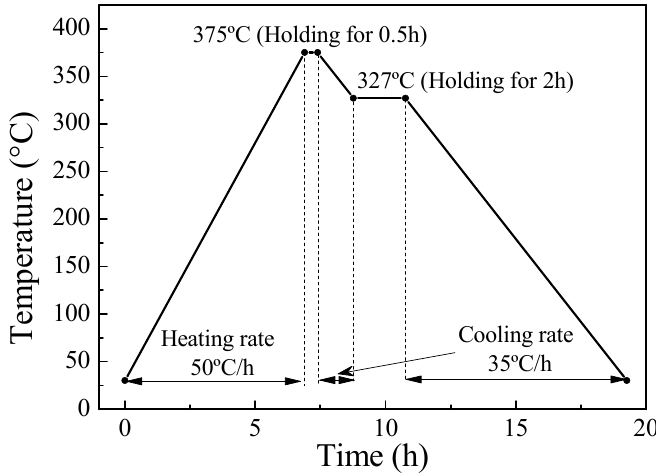
Figure 3. The temperature control procedure during sintering.